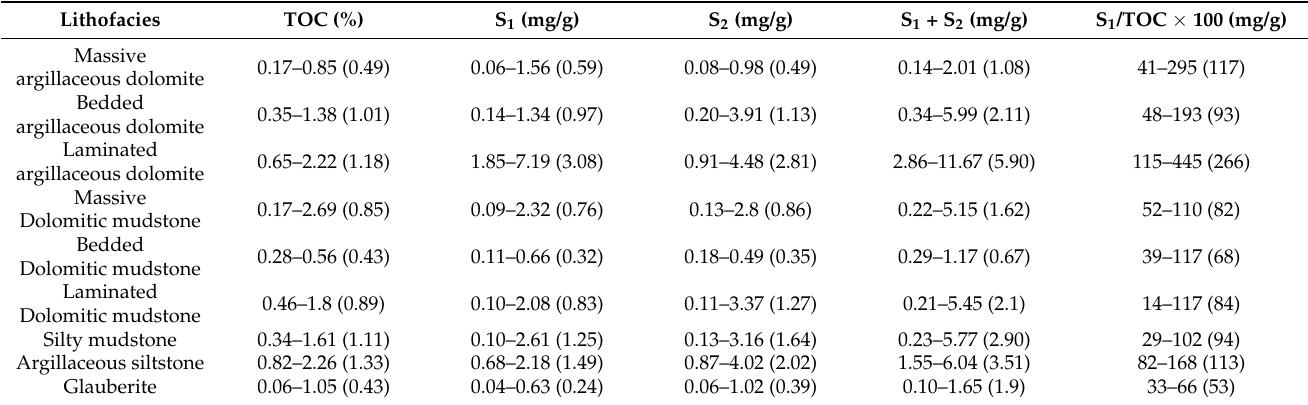
Table 3. Organic geochemical parameters of different lithofacies.